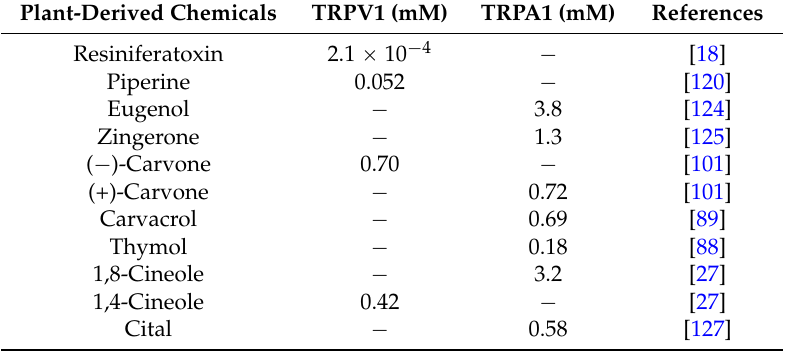
Table 1. EC 50 values for plant-derived chemicals in activating TRPV1 and TRPA1 channels in the adult rat